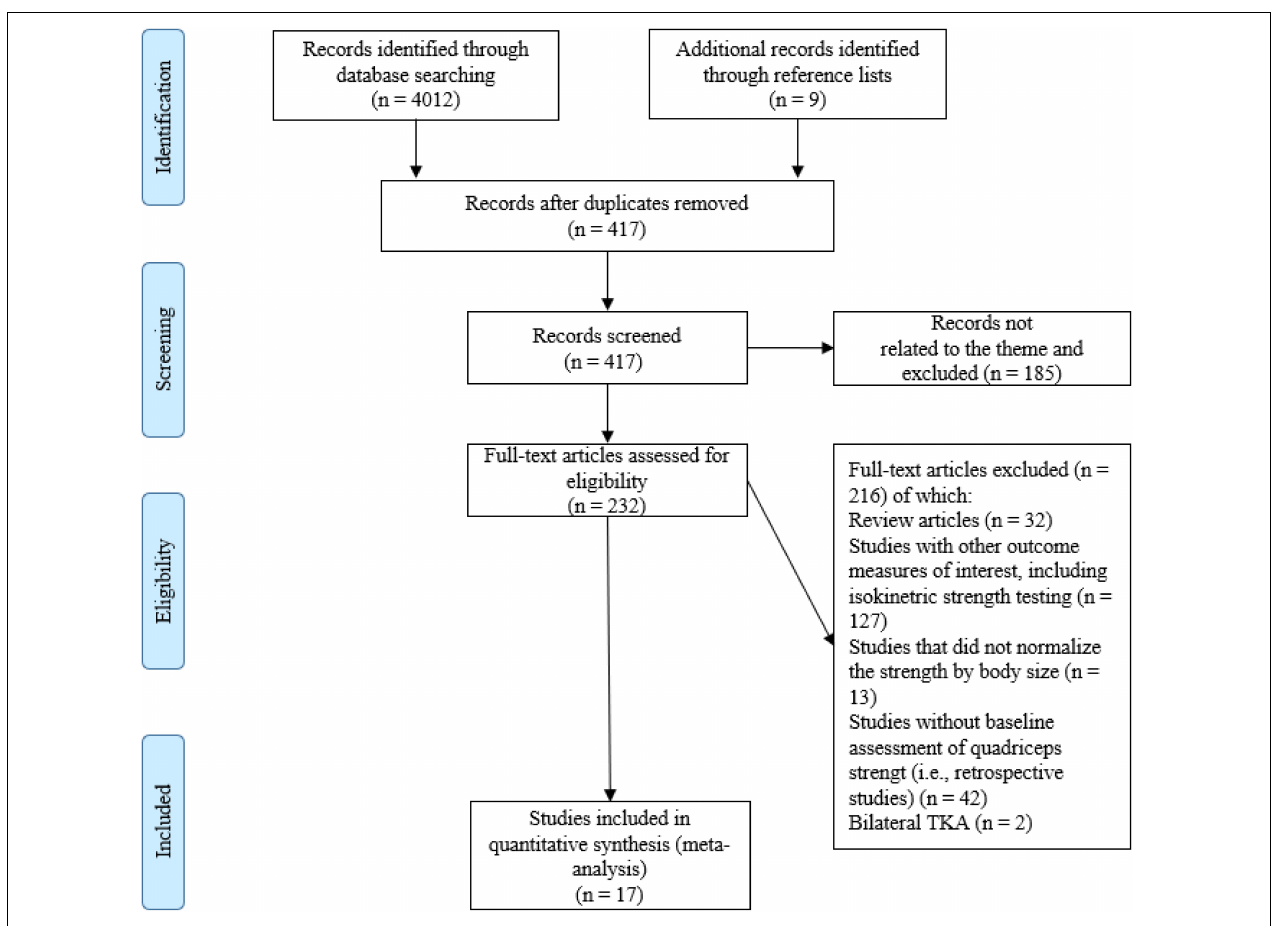
FIGURE 1 | Flow diagram of the process of study